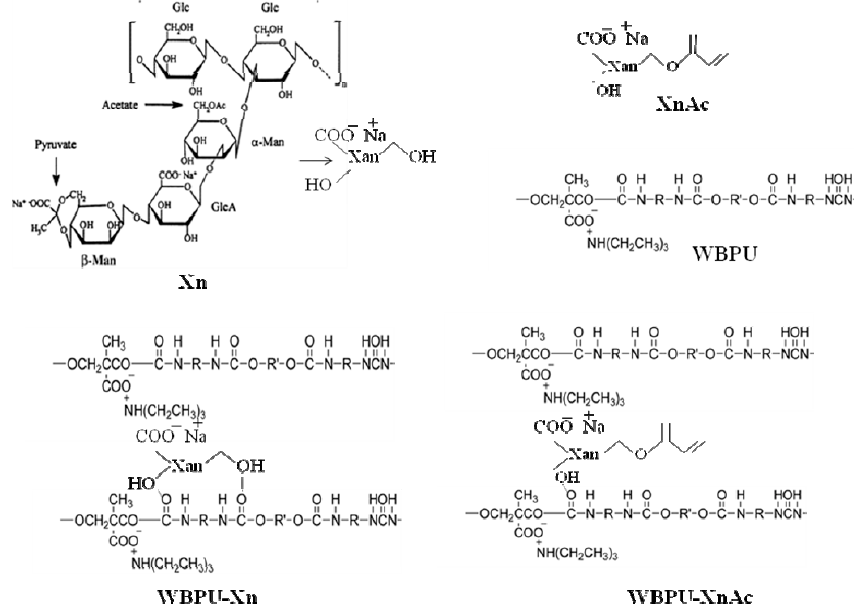
Figure 1. FT-IR spectra of Xn and XnAc polymers.